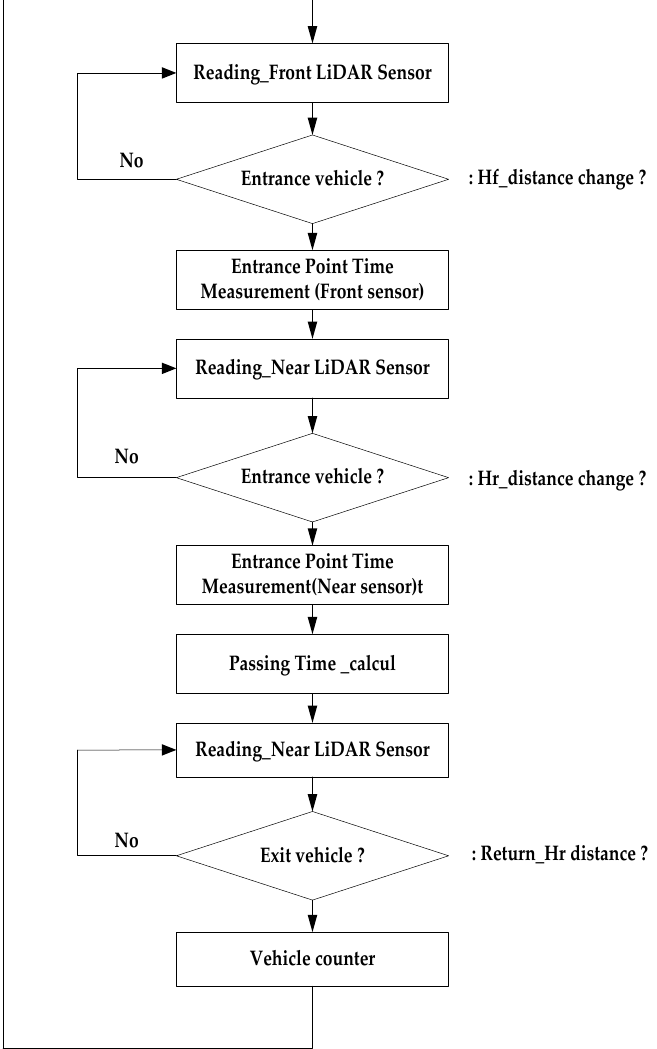
Figure 8. Vehicle measurement time flow chart.